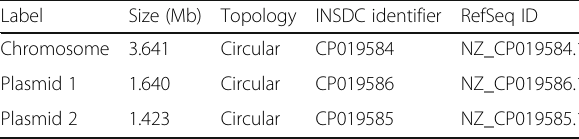
Table 3 Summary of genome: one chromosome and 2 plasmids